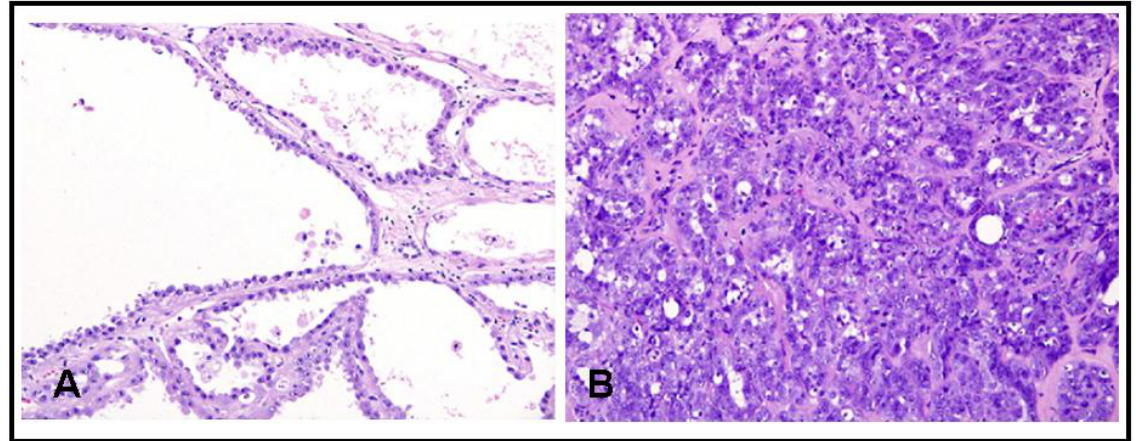
Figure 1. Microscopic appearance of tubulocystic renal cell carcinoma. A, hematoxylin and eosin (H & E) staining shows tubulopapillary pattern with cystic spaces lined with cells having hobnail appearance (x200); B, H & E shows tubular and tubulopapillary structures in a hyalinized and fibrous stroma